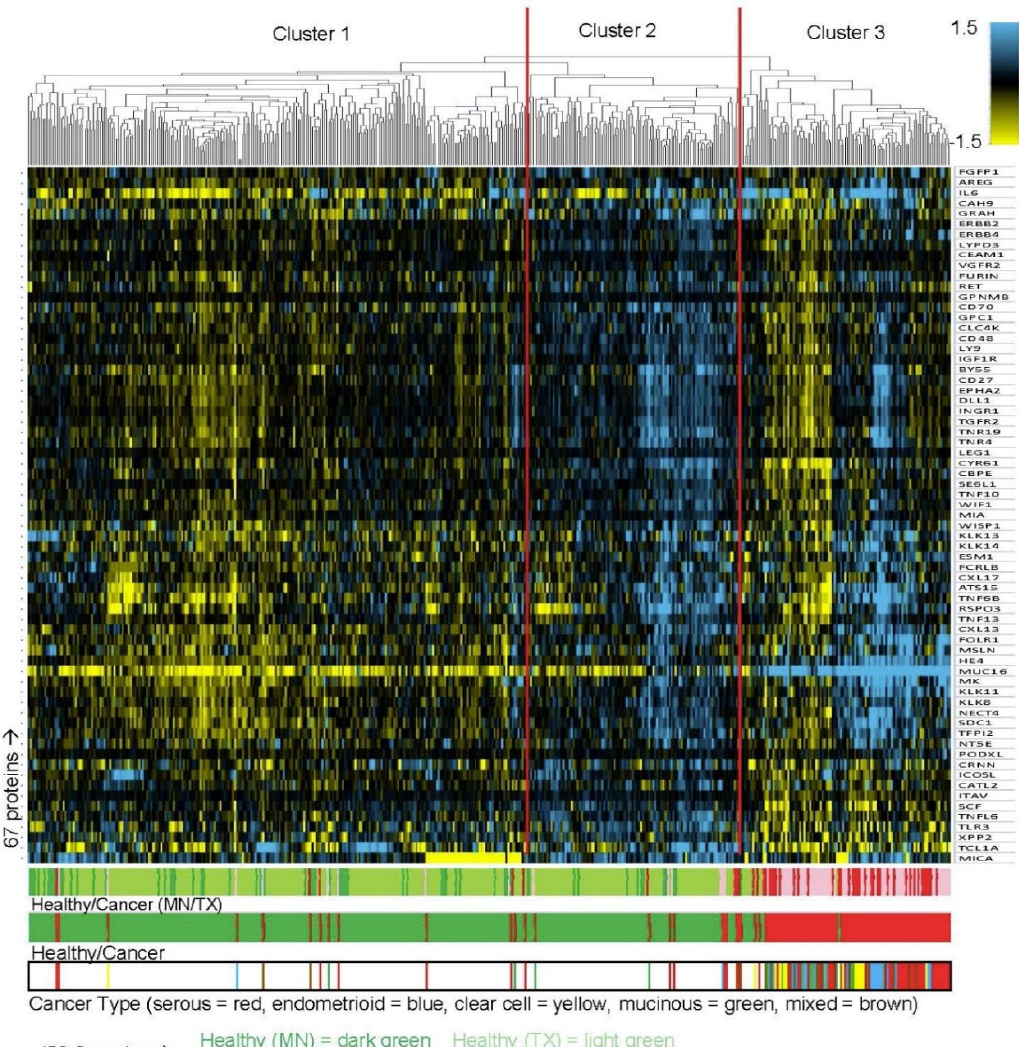
Figure 2. Hierarchical clustering of 452 serum samples from Cohort #1 based on 67 proteins (excluding FOLR3). Blue indicates proteins with high levels of expression, while yellow indicates proteins with low levels of expression. Three major clusters were identified. The three color bands at the bottom identify the samples. Band #1, sample type and institution: Light red, 70 early stage ovarian cancer (TX); dark red, 46 early stage ovarian cancer (MN); light green, 275 healthy (TX); dark green, 61 healthy (MN). Band #2, overall sample type: 116 cancer (red) and 336 healthy (green). Band #3, ovarian cancer subtypes: 53 serous (red), 21 endometrioid (blue), 14 clear cell (yellow), 15 mucinous (green), and 13 mixed